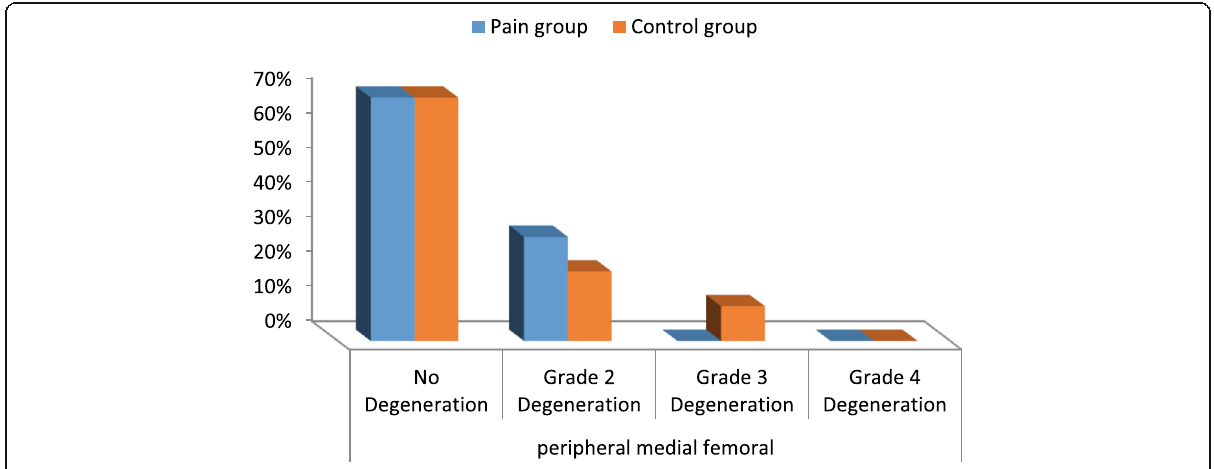
Fig. 7 Distribution of peripheral medial femoral degeneration according to ICRS degeneration grades